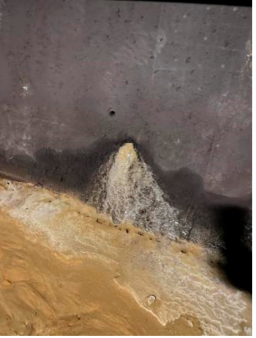
Figure 3. Tunnel drainage pipe blockage by crystals.